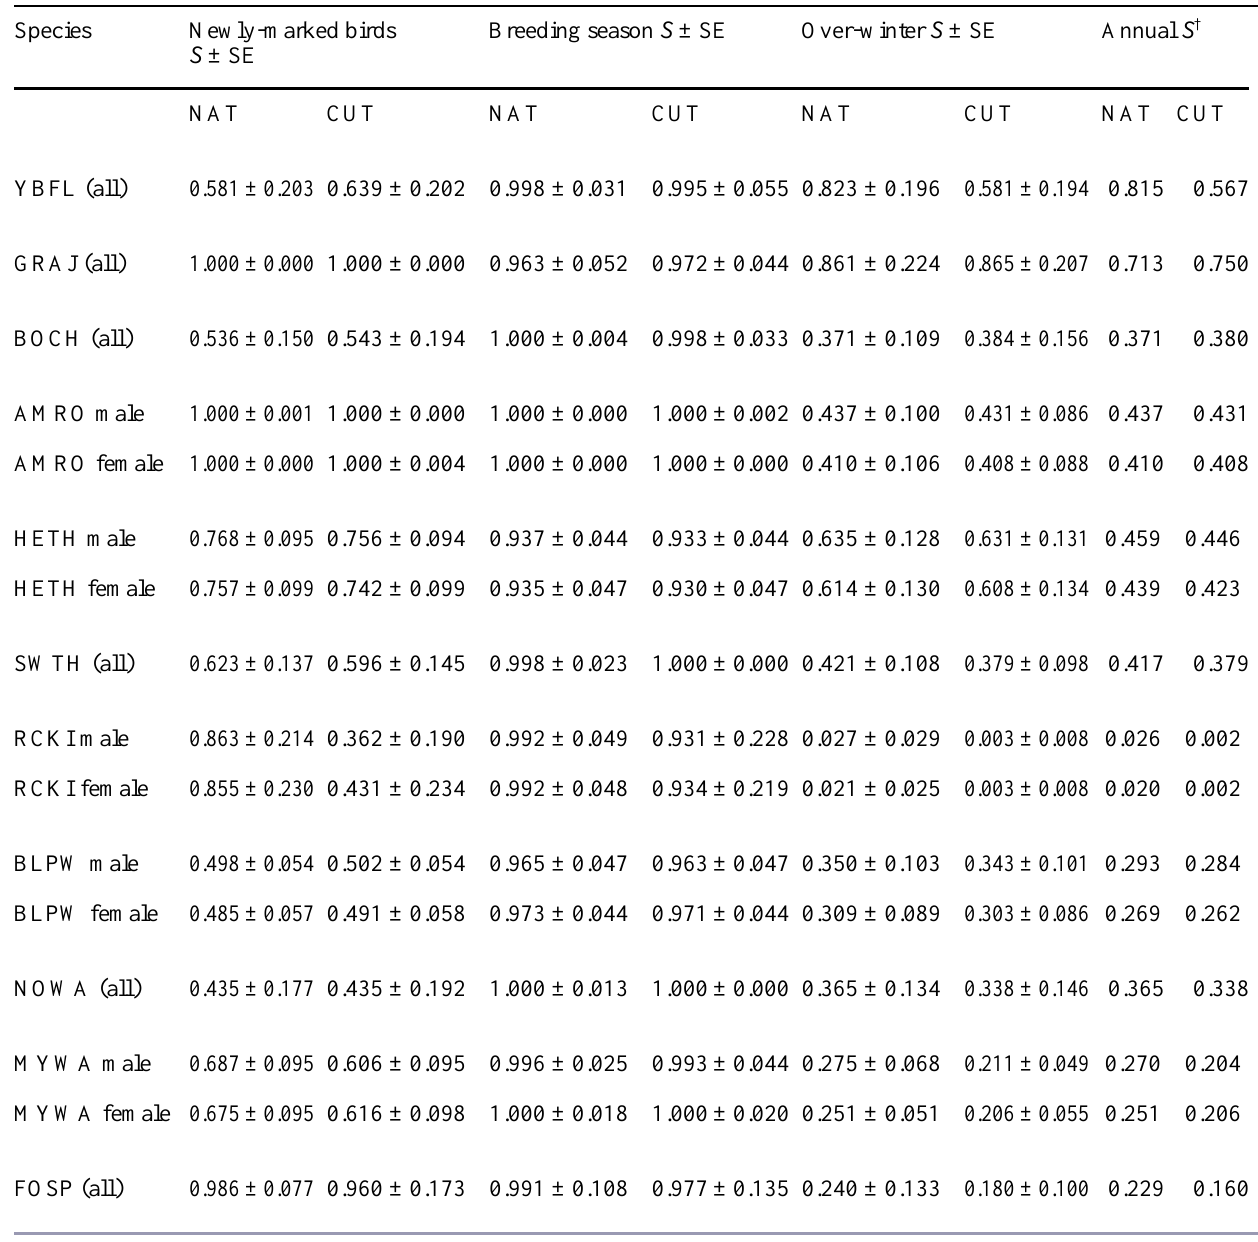
Table 3. Model-averaged apparent survival estimates ± SE by species and when applicable, sex for birds inhabiting boreal forest landscapes having either natural open areas (NAT) or clearcuts (CUT), 2003–2006. We report unconditional standard errors, which take variance from each model and model selection uncertainty into account. Species codes are from Table 1, whereas model sets used to calculate model- averaged survival estimates are presented in Table 2. † As the seasonal survival rates were estimated for five breeding season intervals and one over winter interval, annual survival was calculated as ((breeding season S ) 5 ×(over winter S